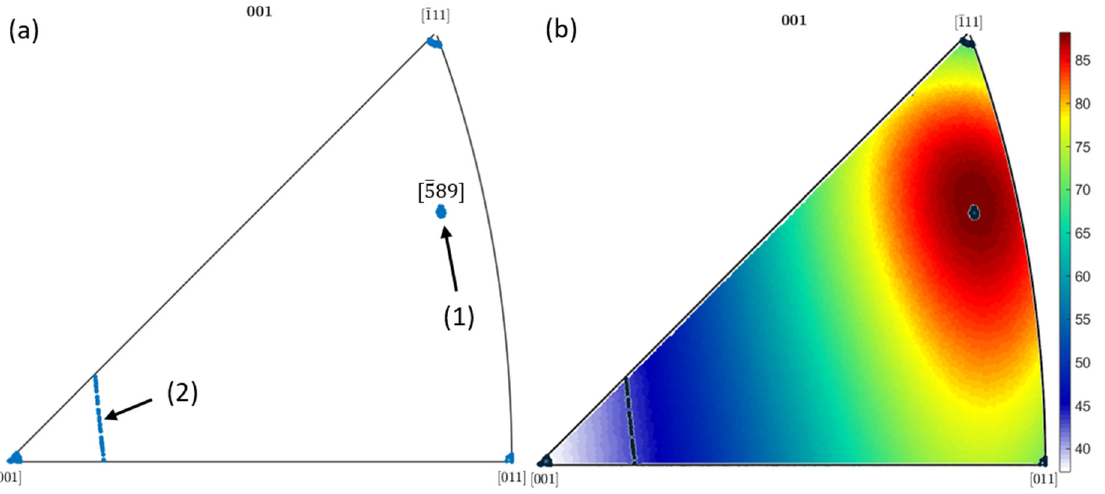
Figure 3. ( a ) Inverse pole figure of chosen grain orientation distributions and ( b ) 𝐸 ∙ 𝑚 values at 850 °C.